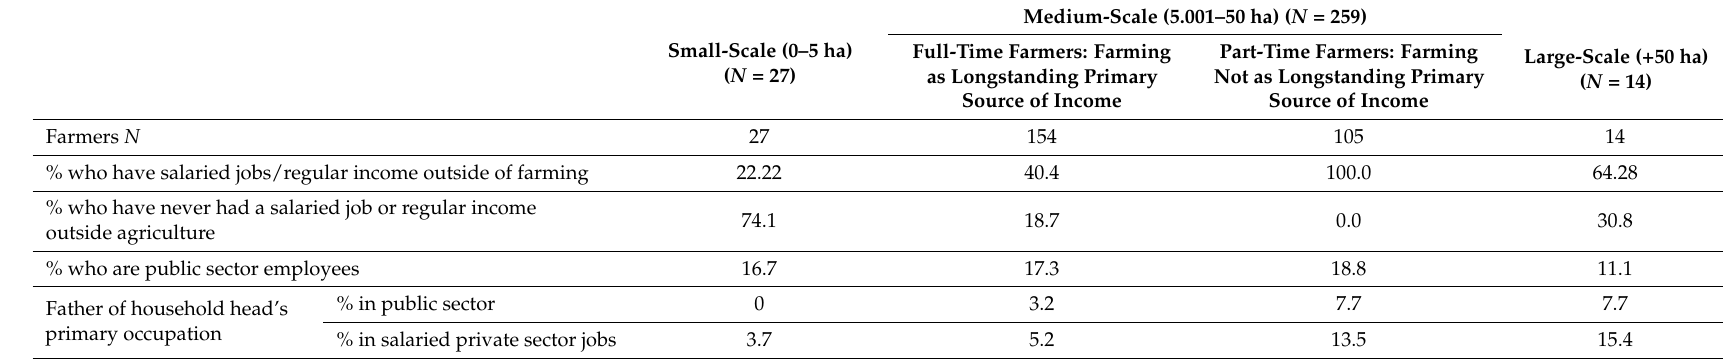
Table 3. Multiple revenue sources of sampled medium-scale farmers * in Mchinji, Lilongwe and Kasungu. Source: Authors’ medium-scale farm survey in the Mchinji, Kasungu and Lilongwe Districts undertaken by LUANAR, UP, and MSU (2014–2015).